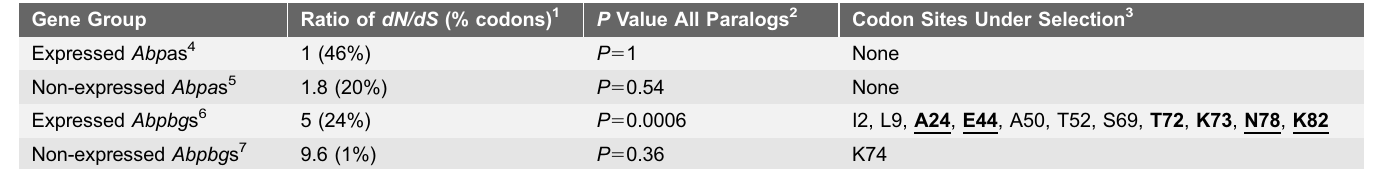
Table 2. Results of the CODEML sites selection test.